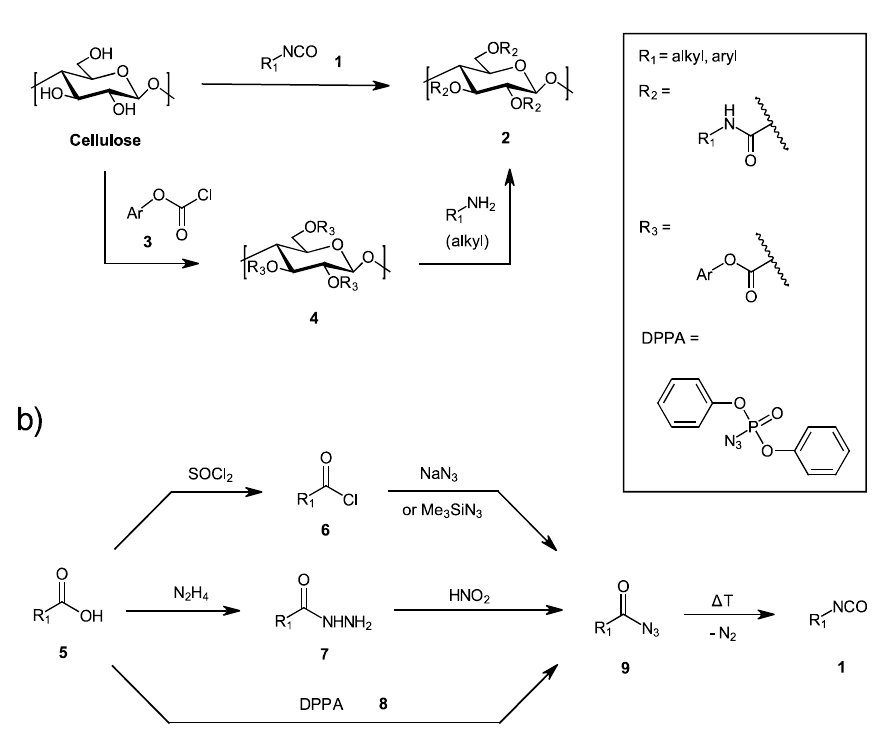
Figure 1. ( a ) Routes towards the synthesis of cellulose carbamates by isocyanate chemistry or carbonate aminolysis; ( b ) Preparation of acyl azides and—after Curtius rearrangement—isocyanates from carboxylic acids.